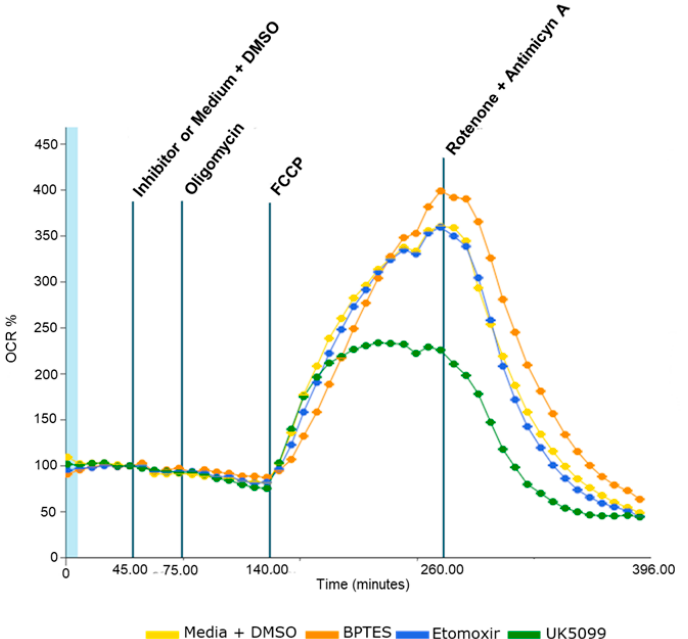
Figure 2. Oxygen consumption rate (OCR) during the bioenergetics assay. Inhibitors of the pyruvate carrier (UK5099), glutaminase 1 (BPTES) and carnitine palmitoyltransferase 1 (Etomoxir) were used to evaluate the contribution of pyruvate, glutamine and fatty acid metabolism, respectively, for VAT OCR. DMSO with no inhibitor was used as control. Oligomycin (an ATP synthetase inhibitor), carbonyl cyanide p-trifluoromethoxyphenylhydrazone (FCCP, a mitochondrial oxidative phosphorylation uncoupler) and a combination of rotenone and antimycin A (mitochondrial complexes 1 and 3 inhibitors) were added in order to modulate the electron transport